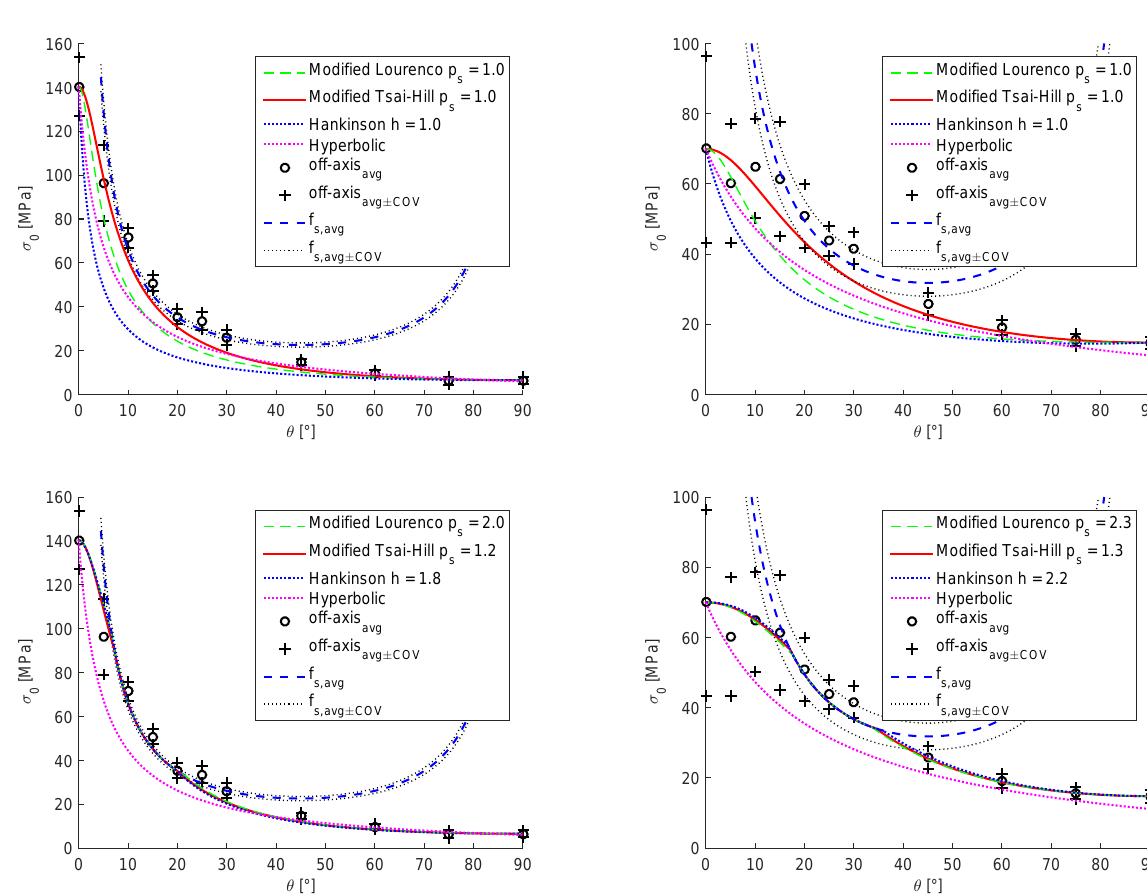
Figure 1. The experimental data of Sitka spruce [7] with uncalibrated (top) and calibrated (bottom) failure conditions.